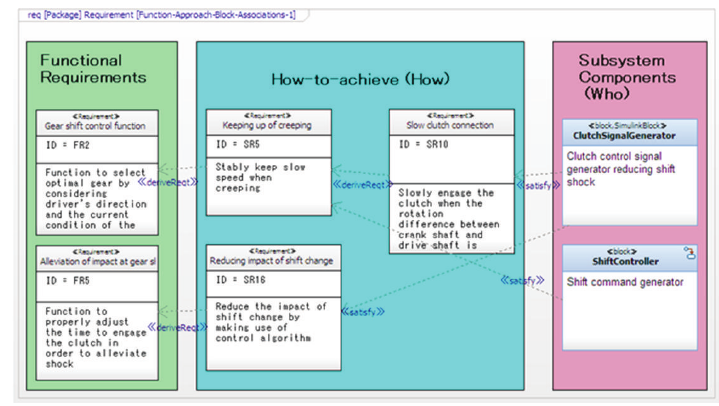
Figure 11: Assign functional requirements to subsystem